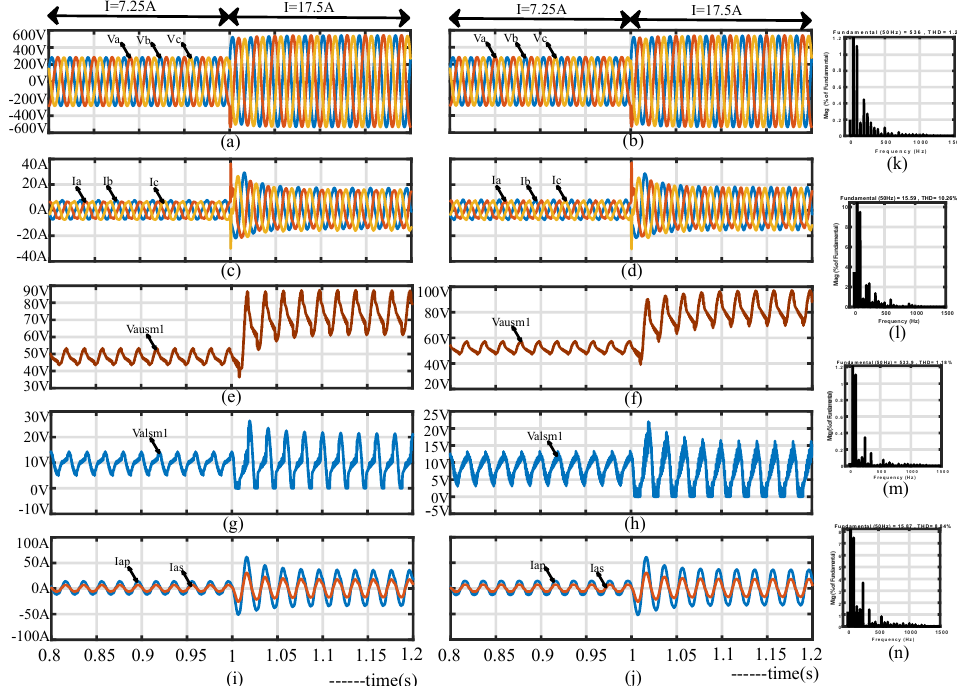
Figure 11. Change in current. ( a ) Line voltages of converter with d-q control and STHILSC, ( b ) line voltages of converter with d-q control and STHIPSC, ( c ) line currents of converter with d-q control and STHILSC, ( d ) line currents of converter with d-q control and STHIPSC, ( e ) STHILSC implemented upper arm phase-a SM-1 capacitor voltage, ( f ) STHIPSC implemented upper arm phase-a